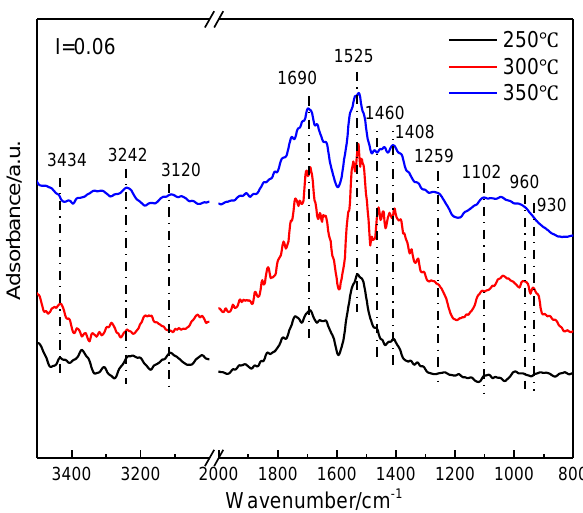
Figure 3. DRIFT spectra of SSOC in the condition of 1000 ppm NH 3 at 250–350 ◦ C for 30 min.